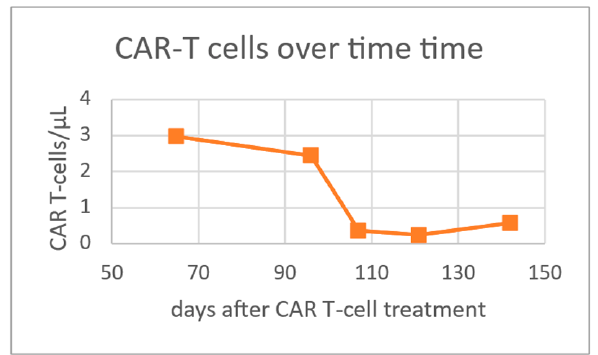
Figure 3. Course of CAR-T cell levels over time.